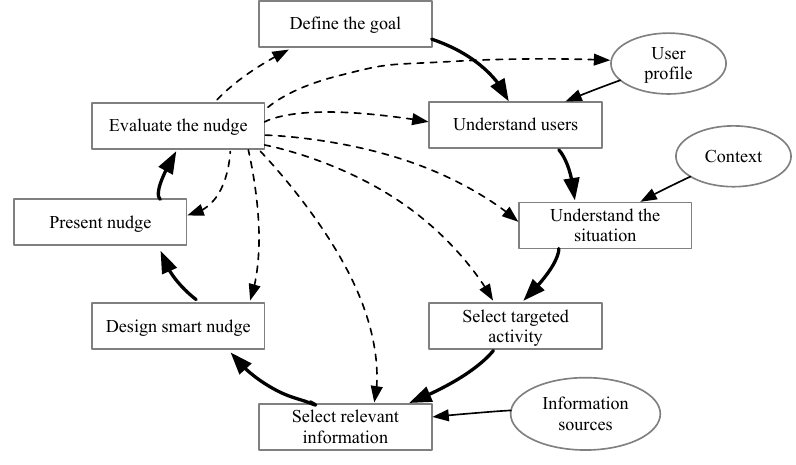
Figure 1. Designing a smart